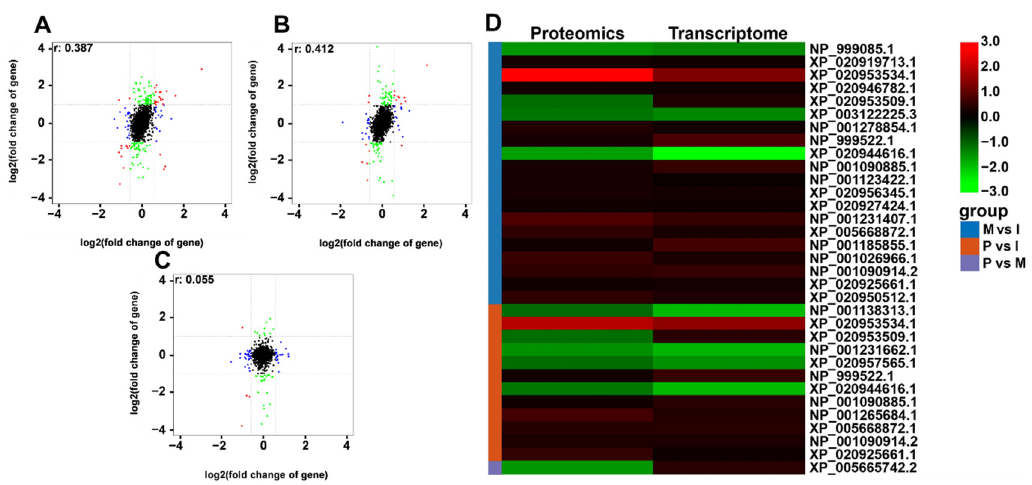
Figure 4. Correlation analysis of proteomics and transcriptome. ( A – C ) The correlation analysis of proteomics and transcriptome in M vs. I, P vs. I, P vs. M. In related analysis diagram, DEGs level for absolute fold change (|log2 fold change|) = 1, and the DEPS was absolute fold change (|log2 fold change|) = 0.585 as thresholds for Pearson correlation analysis. Red indicates that the transcript and protein levels are significantly differentially expressed. Blue indicates that the protein levels are significantly differentially expressed. Green indicates that the transcript levels are significantly differentially expressed. Black indicates that the transcript and protein levels are not significantly differentially expressed; ( D ) The expression pattern clustering analysis for 33 DEGs and DEPs with correlations. Red indicates up-regulated, and green indicates down-regulated.